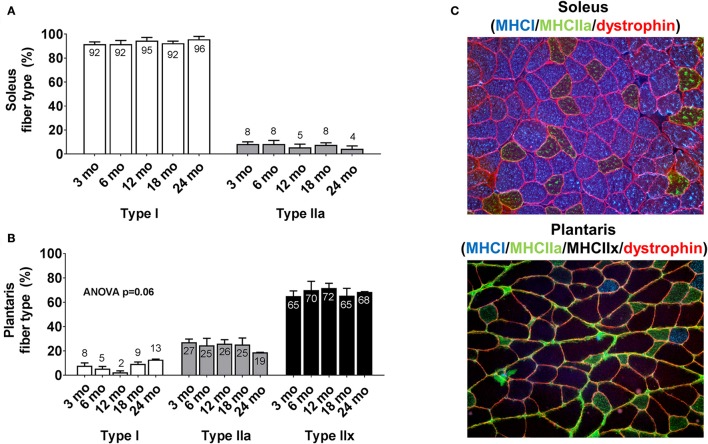
Plantaris and soleus fiber type distribution differences between age groups. Age group differences in soleus fiber type (A) and plantaris fiber type (B). Data are presented as mean + SE and mean values for each dependent variable are presented within each bar. (C) Illustrates representative 20x objective micrographs of each stain. mo, month.